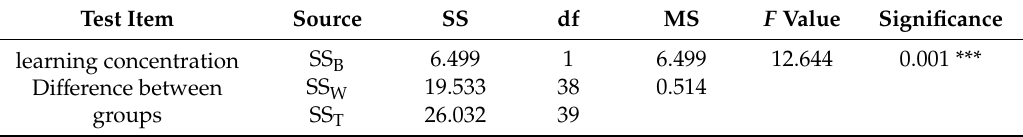
Table 5. One-way ANOVA on student learning concentration for two groups of learning